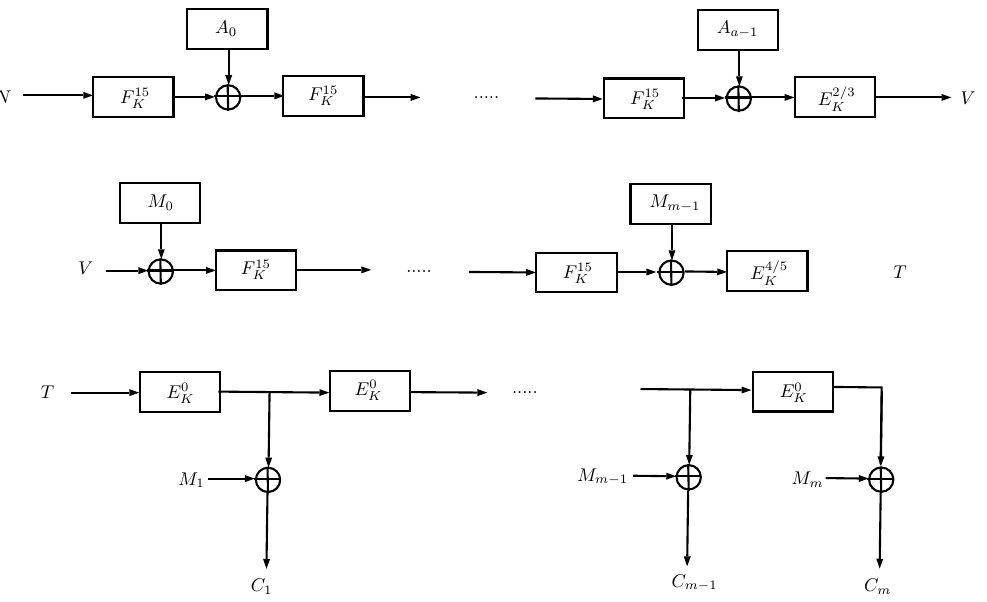
Figure 7. ESTATE deterministic authenticated cipher.